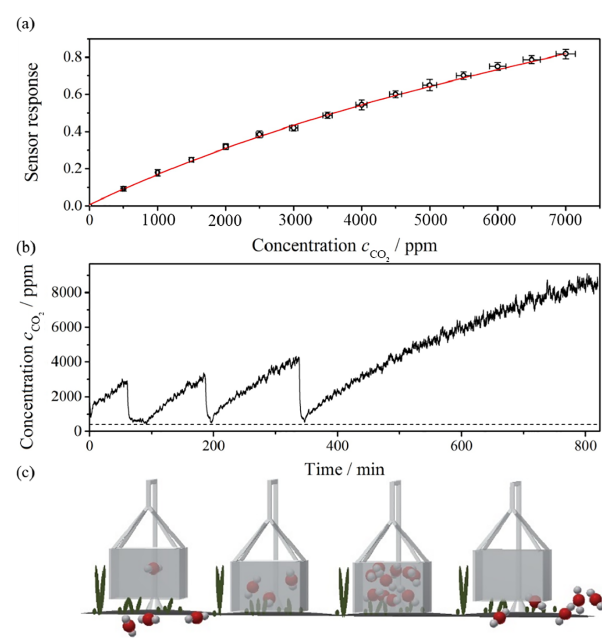
Figure 5. Calibration of the experimental CO 2 photoacoustic NDIR device and proof-of-principle measurement. The calibration mea- surement reveals a non-linear sensitivity, which limits the resolution capabilities in the high concentration range. The proof-of-principle measurement demonstrates the capability of the sensor device to monitor the dynamics of plant respiration with an adequate tempo- ral